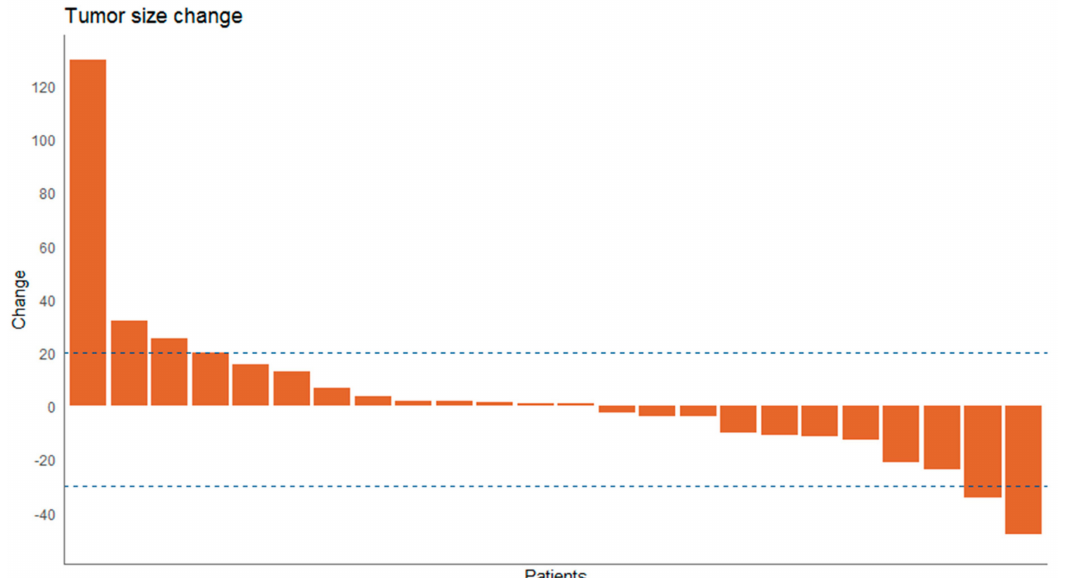
Figure 1. Waterfall plot of tumor response depicted as percentage of tumor volume change phase I and II combined for the patients of phase I that received prior treatment with FOLFIRINOX and treatment with LDE225 200 mg.